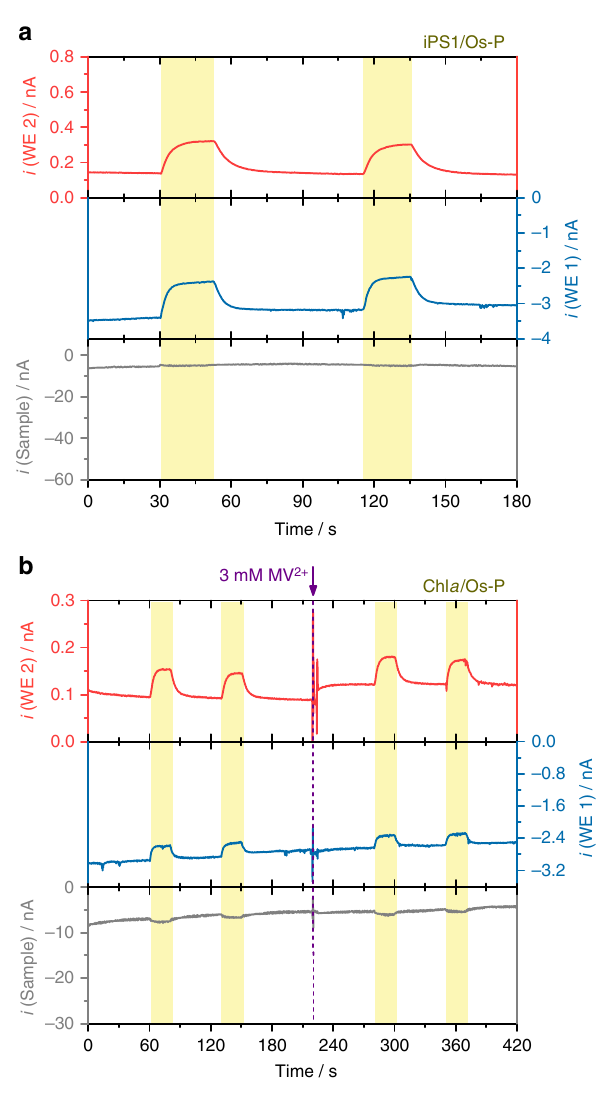
Fig. 5 Production of partially reduced oxygen species at inactivated PS1 and free Chl a under irradiation. Simultaneous photochronoamperometric responses recorded for a iPS1/Os-P and b free Chl a /Os-P-modi fi ed electrodes. Electrolyte: 3 mM MV 2 + in 0.2 M citrate-phosphate buffer, pH 7.0 (for b addition of MV 2 + at 220 s). The sample was polarized at 0 mV, while the Pt disk microelectrodes were polarized at − 600 mV (WE 1) and + 600 mV (WE 2). All potentials vs. Ag/AgCl/3 M KCl. Tip-to-sample distance: 10 μ m. The sample was locally irradiated (white light, 280 mWcm − 2 ) for periods of 20 s, as indicated by the yellow shaded regions in